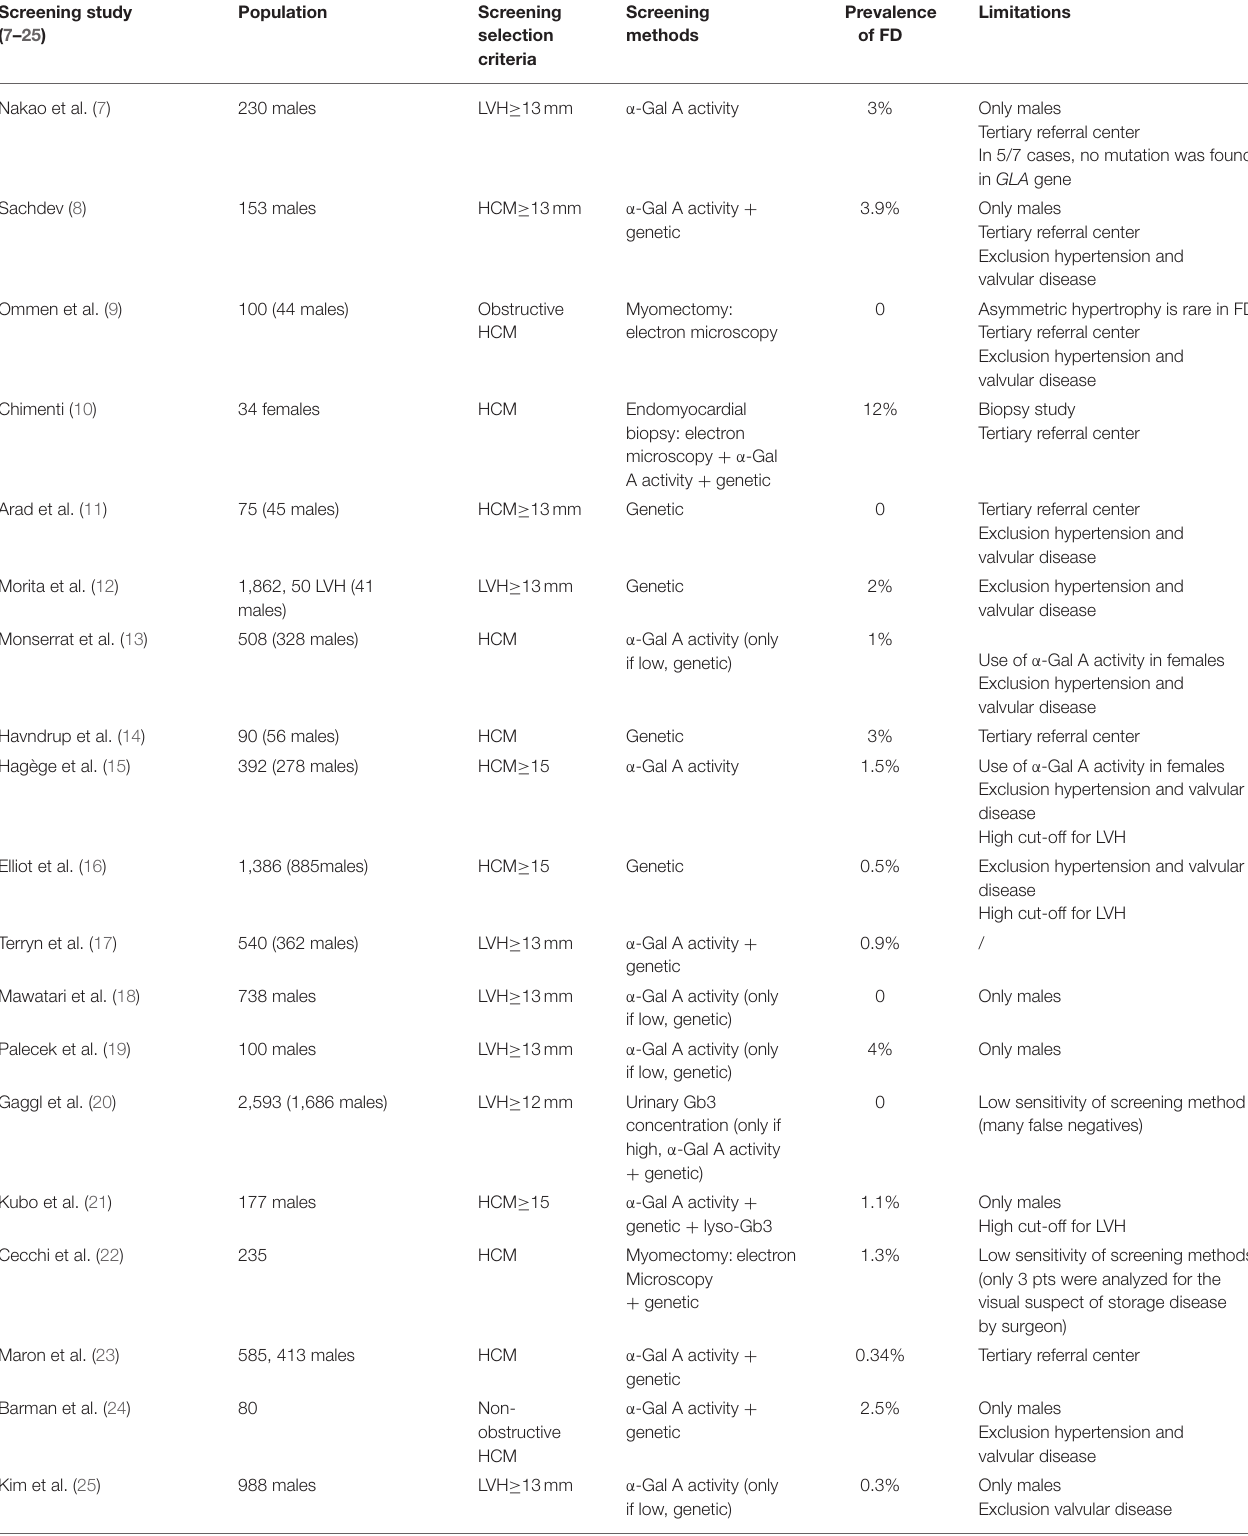
TABLE 1 | Previous screening studies of FD in patients with